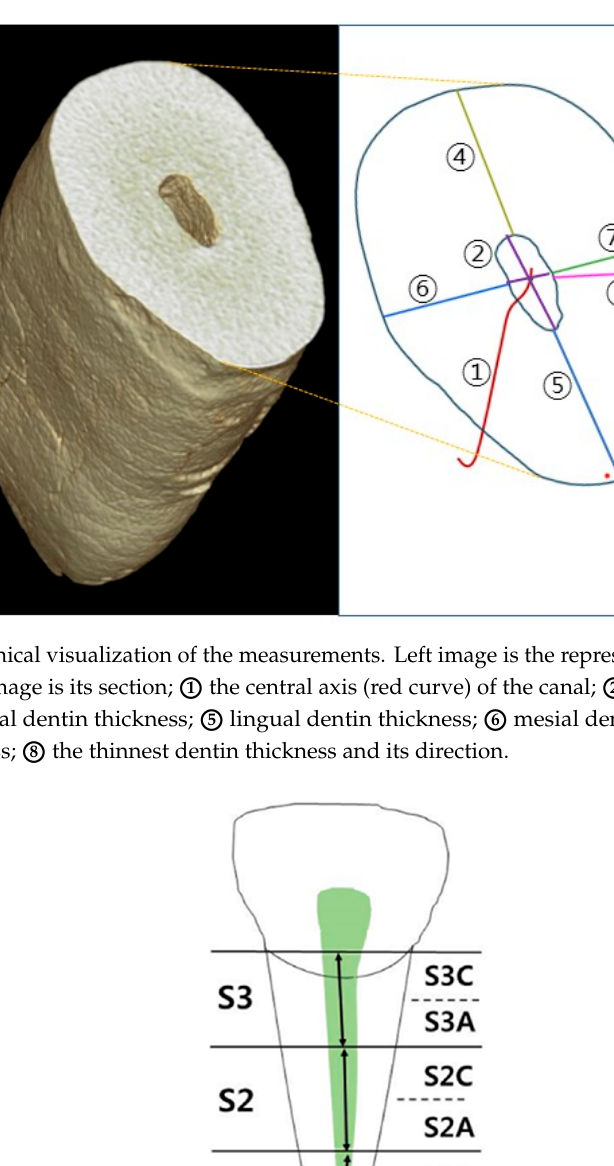
Figure 4. Axial level of the root canal